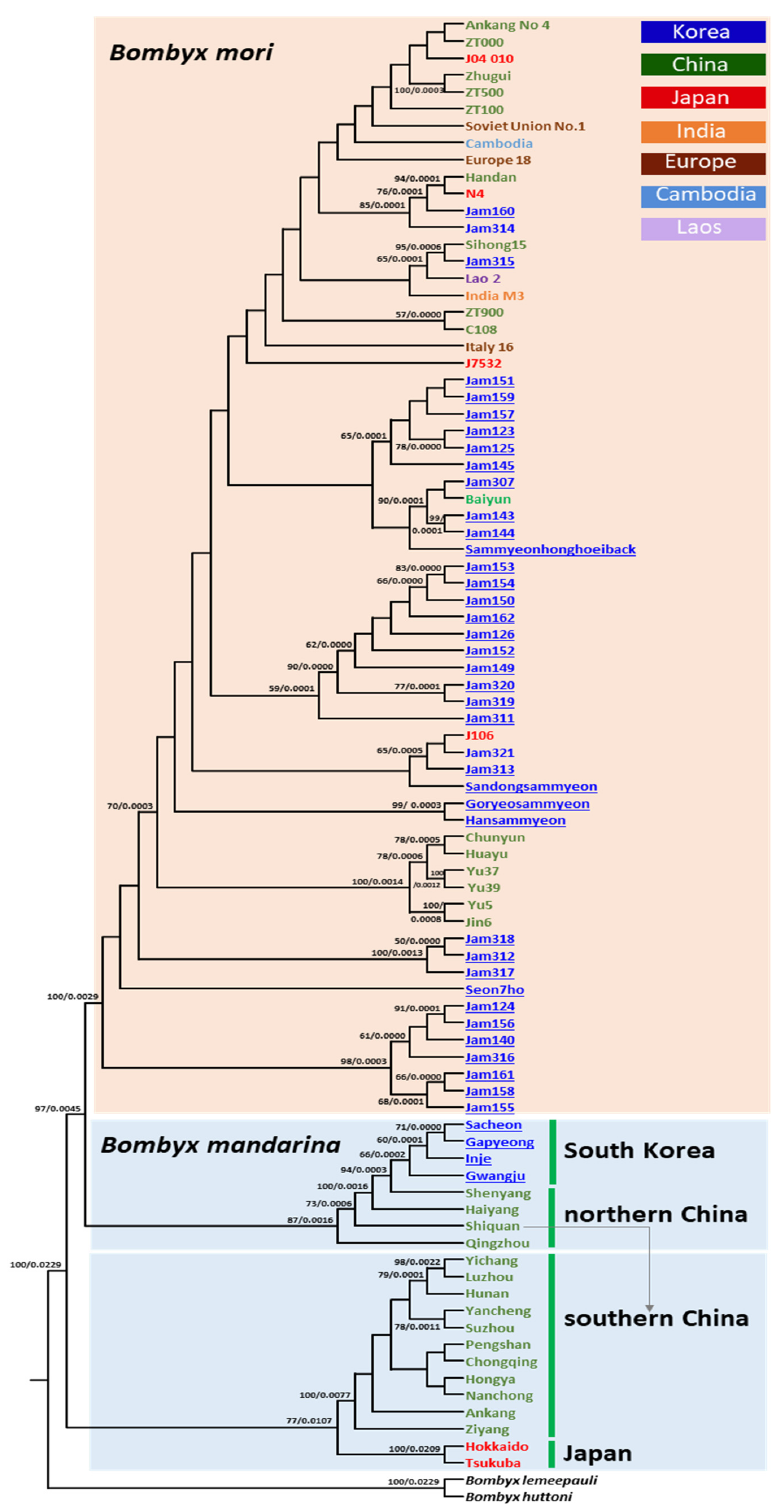
Figure 6. Phylogenetic relationships among Bombyx mori and B. mandarina haplotypes using the maximum-likelihood method. The numbers at each node specify bootstrap percentages of 1000 pseudoreplicates ( first ) and branch length ( second ). The node supports below 50% were omitted. B. mori and B. mandarina haplotypes sequenced in this study are underlined. B. huttoni and B. lemeepauli were used as outgroups.